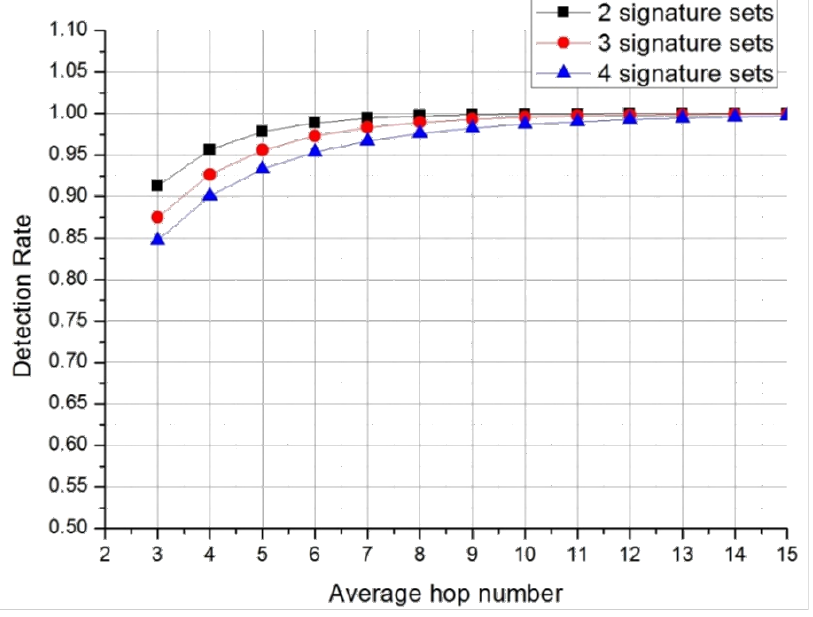
Figure 11. Detection rates when attack signatures are distributed by priority.